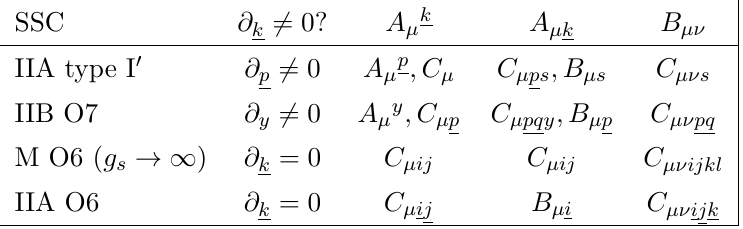
= 0 and B µν have modified Bianchi 6